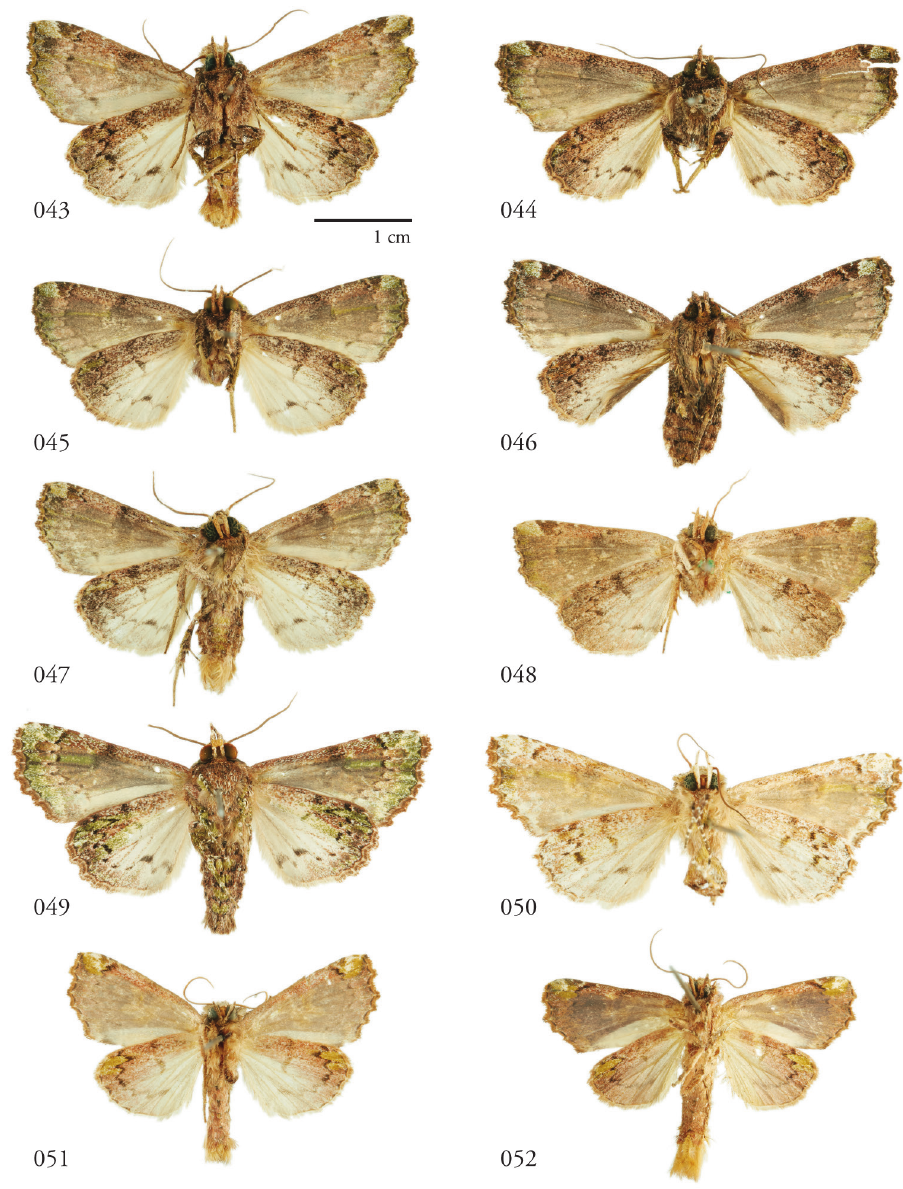
Figures 43–52. Leucosigma ventral habitus. 43 L. sp. nr. schausi, ♂ , Dominican Republic,